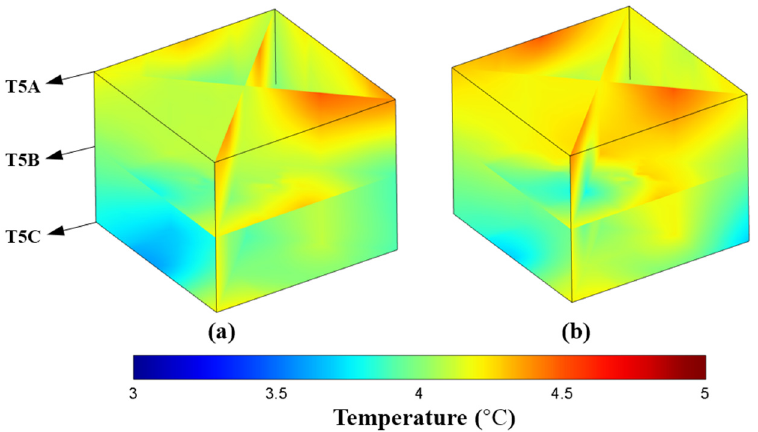
Figure 13. Space distributions of temperatures in the simulated marine sediment from the starting point to the end point of methane seeping. ( a ) 3.3 h, ( b ) 83.3 h. point to the end point of methane seeping. ( a ) 3.3 h, ( b ) 83.3